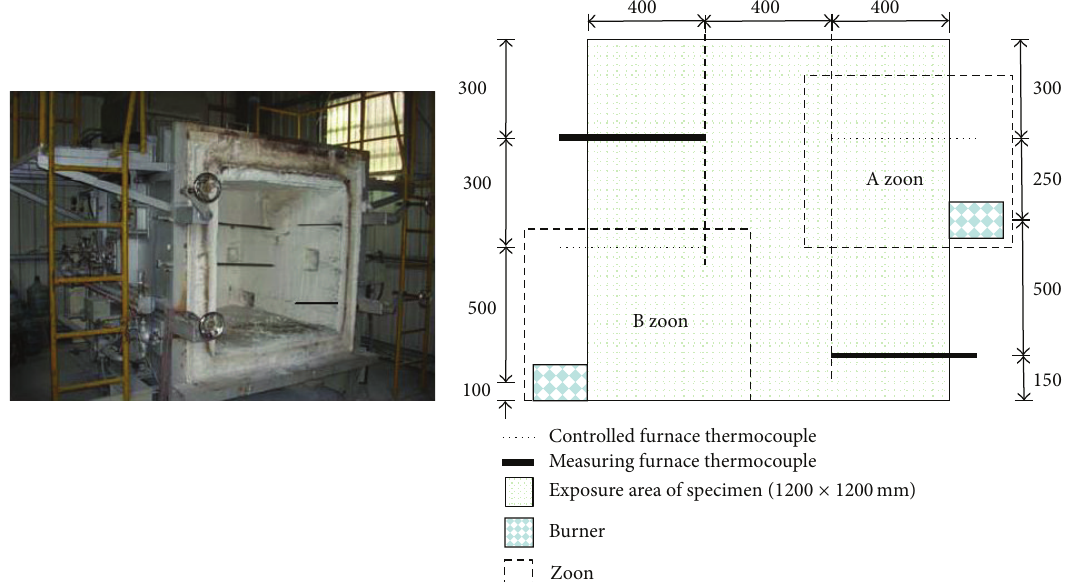
Figure 2: Small-size high-temperature furnace (inner size: 120cm in width, 120 cm in height, and 120cm in